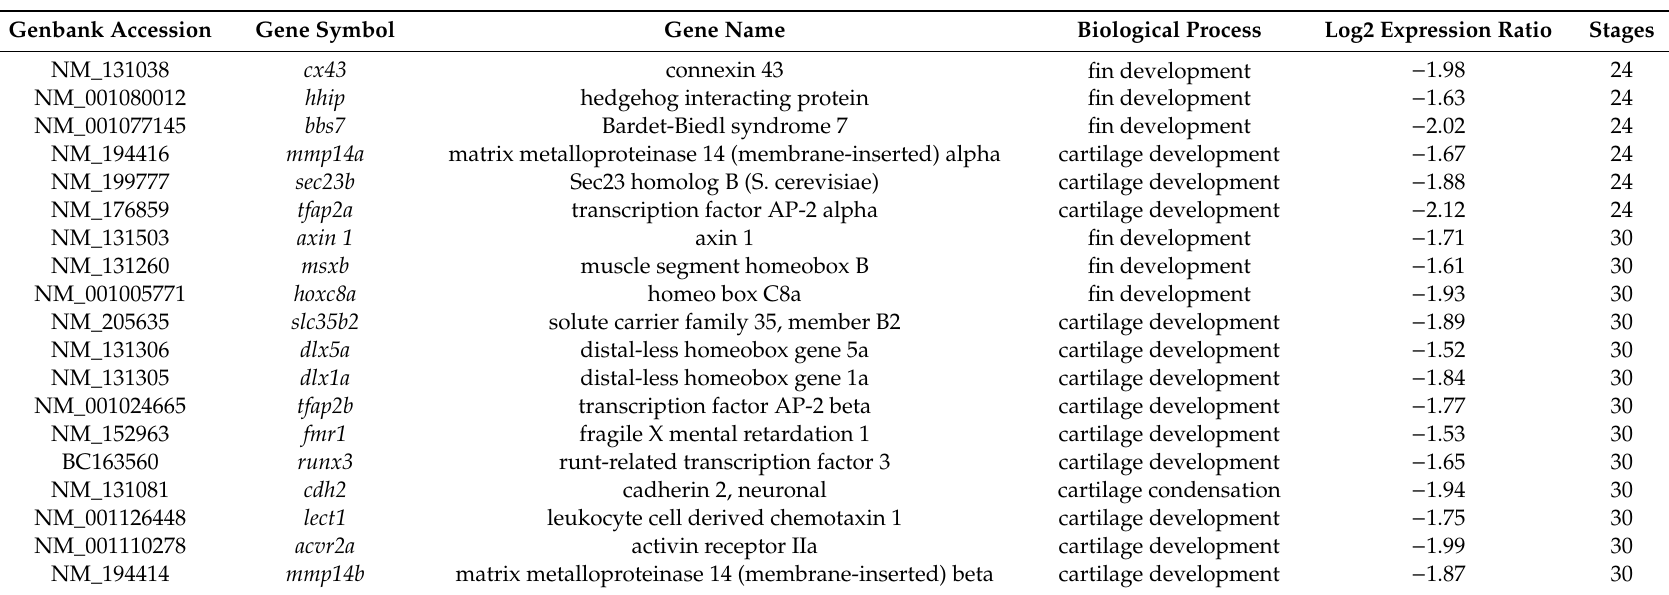
Table 1. Cartilage and fin development-related gene transcripts downregulated 1.5x in tbx5 knockdown embryos in di ff erent embryonic developmental